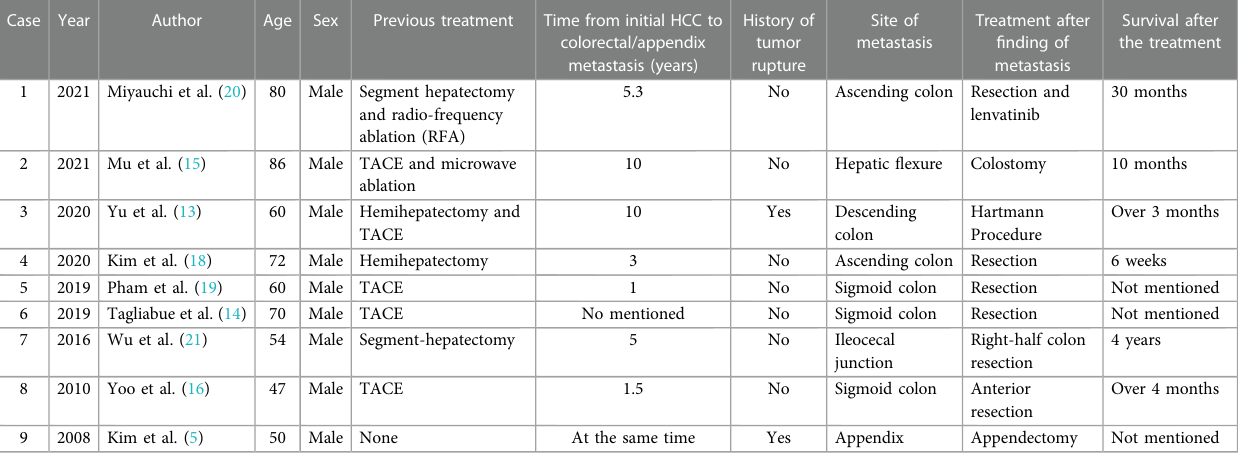
TABLE 1 Summary of cases reported in HCC patients with colon/appendix